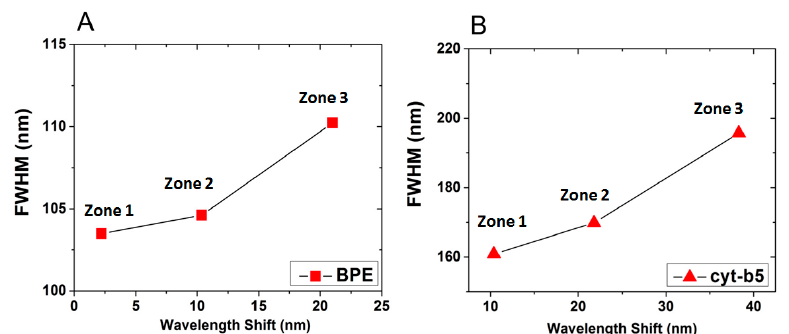
Figure 6. Relation between FWHM and wavelength shift for ( A ) BPE and ( B ) Cyt-b5 molecules using the recorded spectra from three independent zones exposed to drops of specific biomolecules solution namely BPE and Cyt-b5, respectively. Table 2. FWHM and wavelength LSPR maximum shift for AuNPs substrate, with adsorbed BPE and Cyt-b5 for the three selected zones.